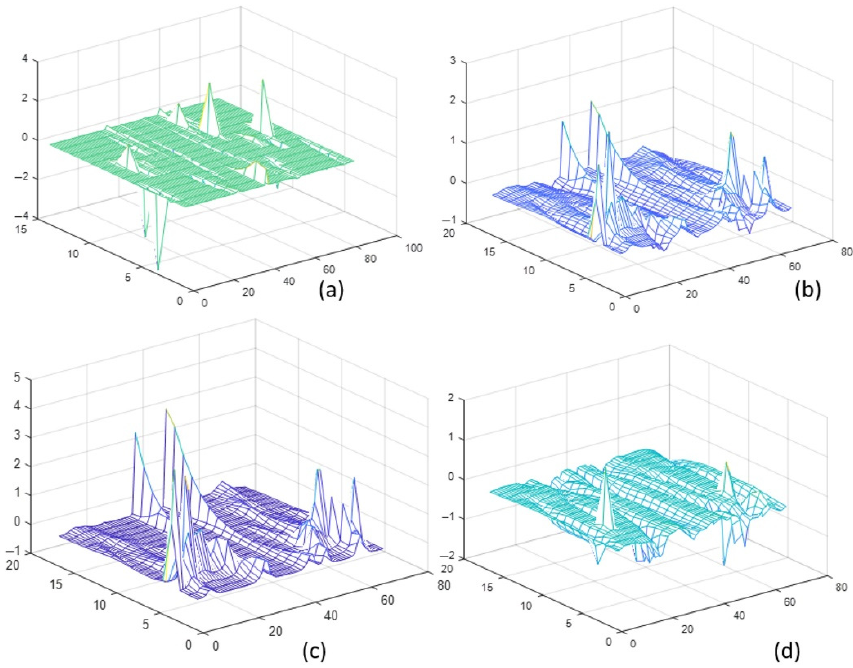
Figure 4. Combination results for ( a ) SS + K , ( b ) SS + H , ( c ) SS + X , and ( d ) SS + N with O = 1 and L = 1 on an eye